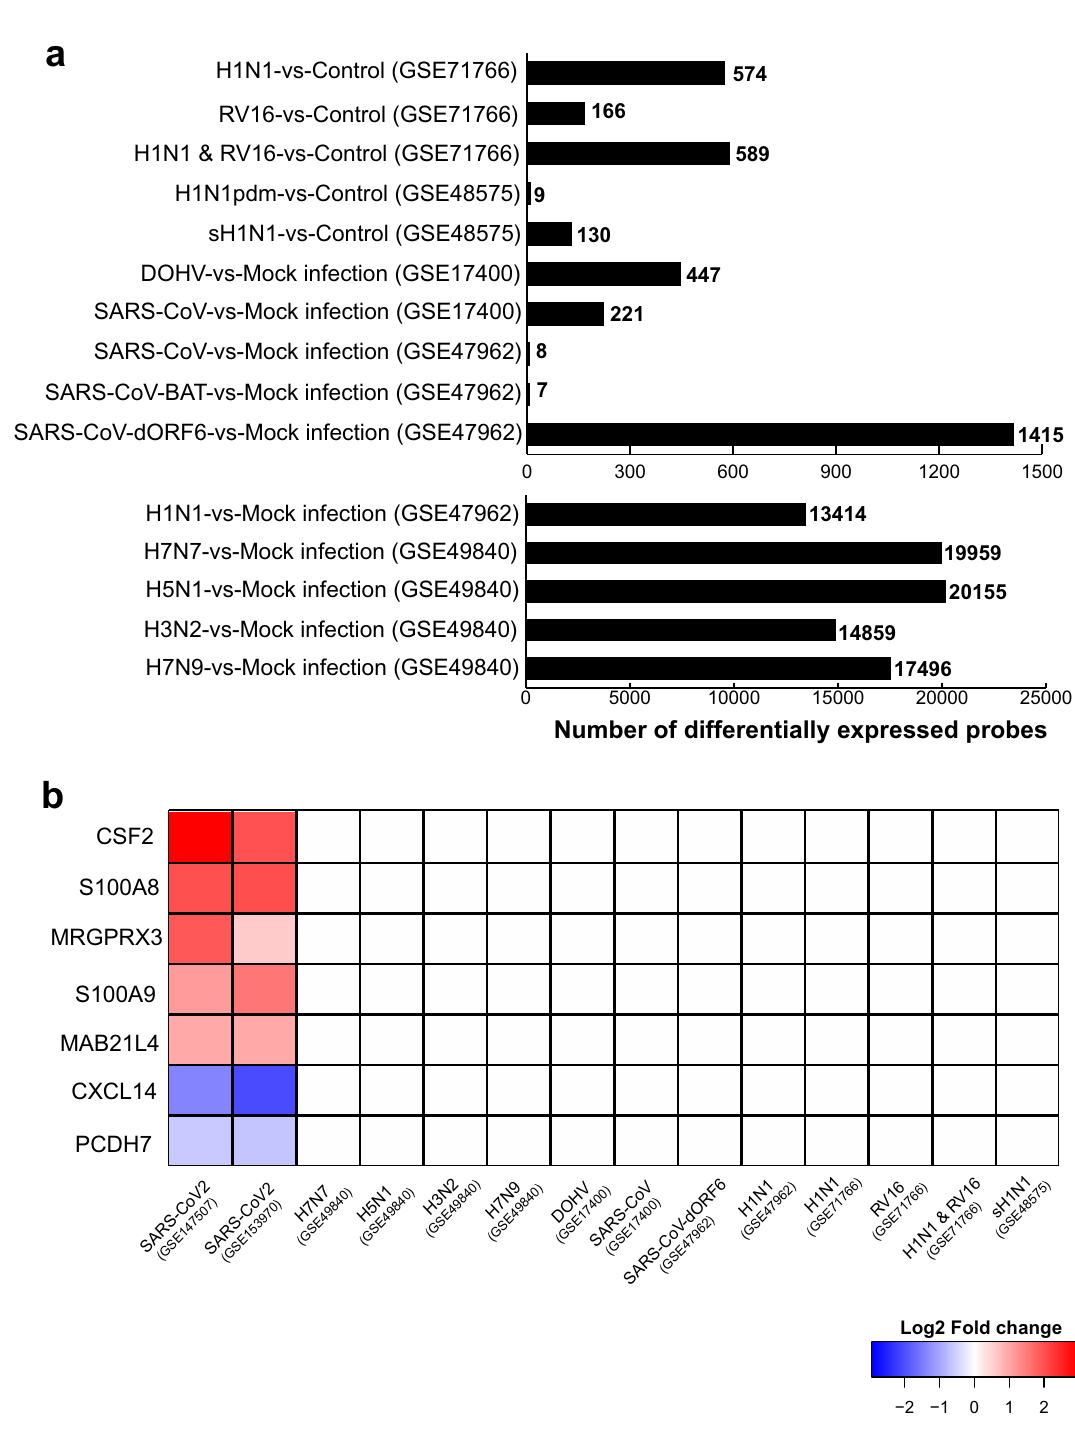
Figure 2. Comparative transcriptome analysis of collected gene expression data. (a) Histogram showing the differentially expressed genes as determined by GEO2R analysis of respiratory viral infection microarray data. (b) Heatmap showing 7 genes exclusively altered on SARS-CoV-2